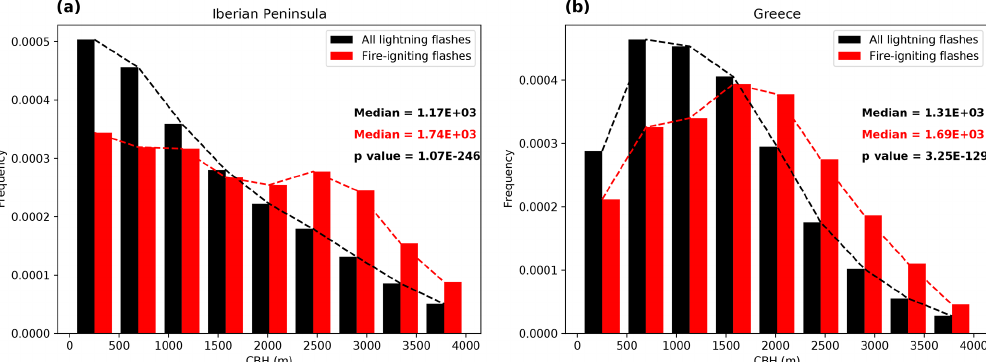
Figure 7. Frequency distribution of the CBH value for the CG lightning and the fire-igniting lightning climatologies in (a) the Iberian Peninsula between 2009 and 2015 and (b) in Greece between 2017 and 2019. Table 2. Median value of the distributions of fire-igniting lightning plotted in Figs. 5–7 for each of the climate zones of the Iberian Peninsula and Greece. We include the median value of the distributions of CG lightning flashes in parentheses and the p values (zero when lower than the machine precision). We also include the median value of the meteorological variables of LCC( > 20ms) lightning, reported by ISS-LIS, taking place in clouds with a high base (Fig. 18) and the CBH of all LCC( > 20ms) lightning (Fig. 20), including the median value of the distributions of typical lightning flashes observed by ISS-LIS in parentheses. Region CAPE Precipitation Wind RH